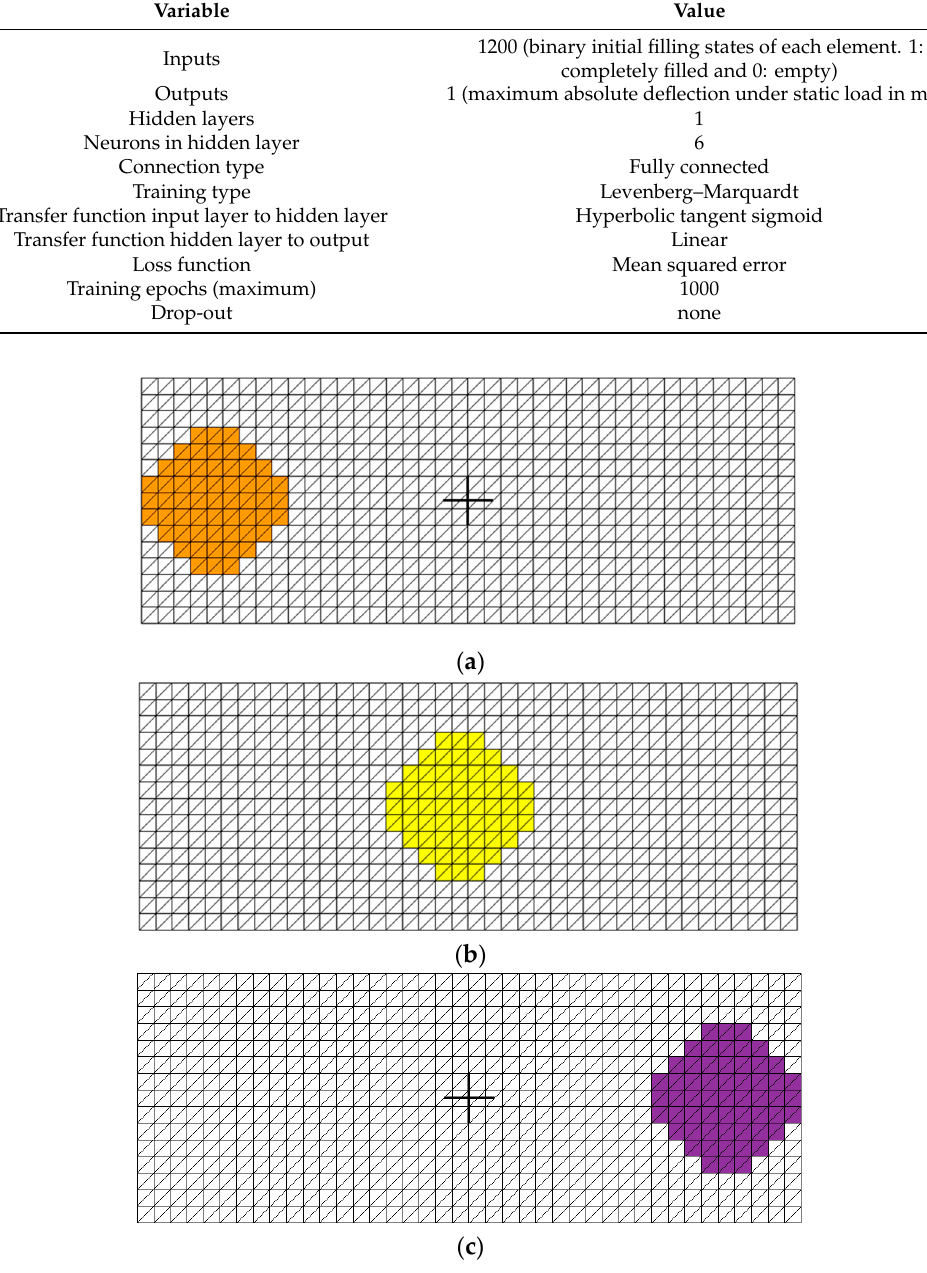
Figure 4. Preform geometries used in initial metamodel validation: validation geometry 1 ( a ), validation geometry 2 ( b ), validation geometry 3 ( c ).